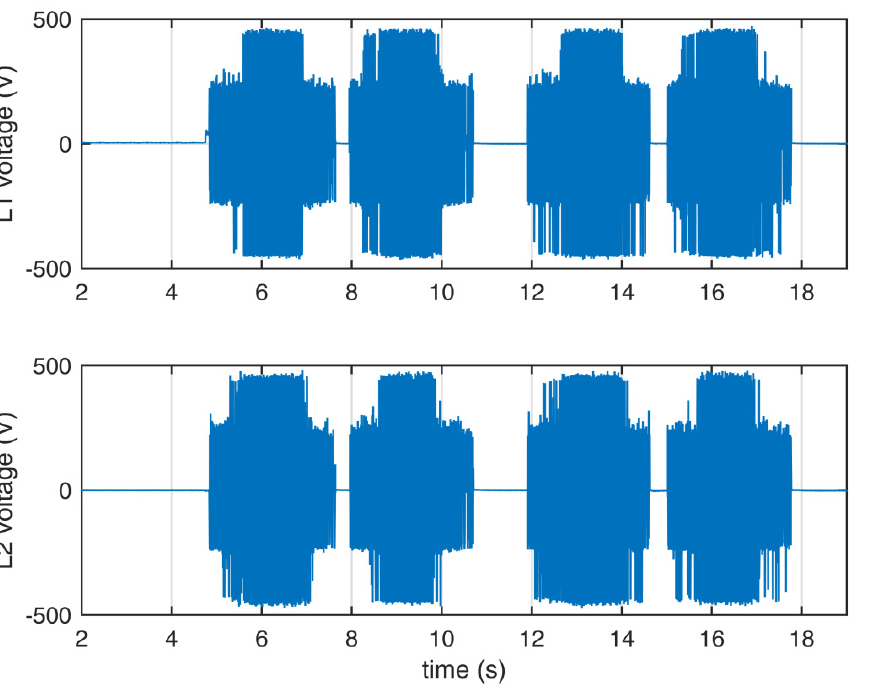
Figure 14. Voltage waveforms of the dynamic state. The first half of the measurement uses set A, while the other half uses set C.